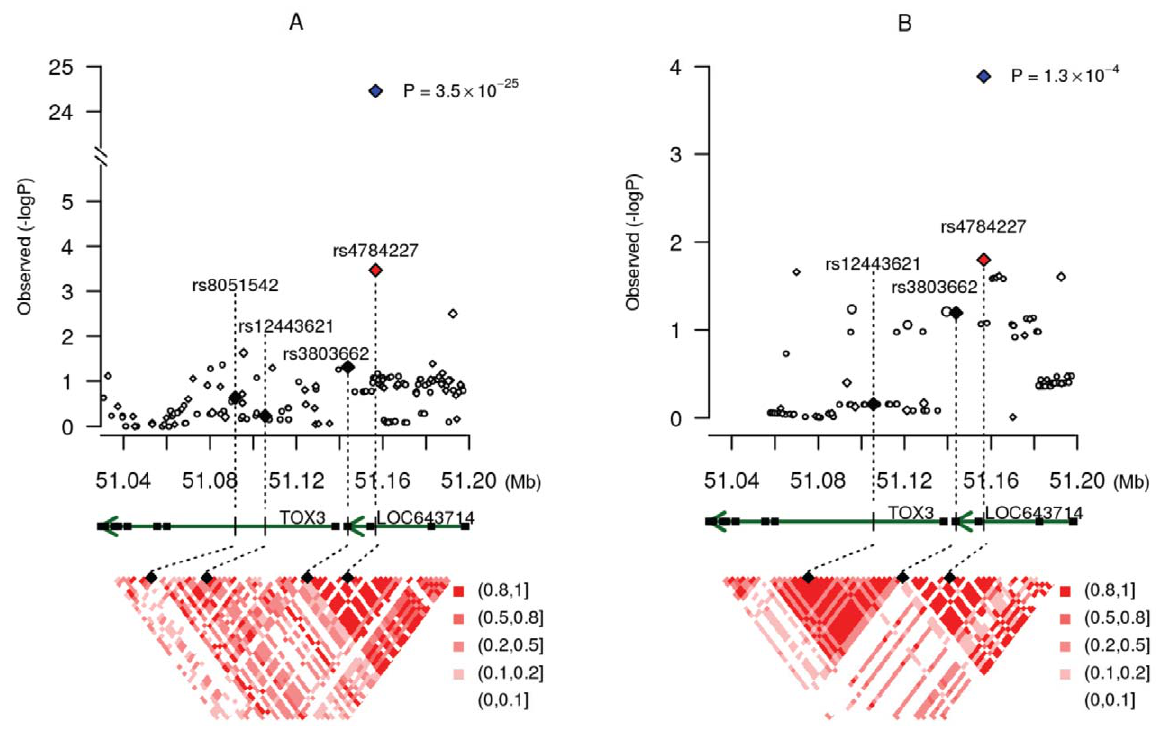
Figure 2. SNP association at 16q12 with breast cancer risk. In SBCS (A) and CGEMS (B). Top panel: Results (-log 10 P) are shown for the associations of breast cancer risk with directly genotyped (diamonds) and imputed (circles) SNPs located in the TOX3 and LOC643714 genes. P-values for rs4784227 are shown in red for Stage I data and in blue for the combined data. The three previously-reported SNPs (rs8051542, rs12443621, and rs3803662) are highlighted in black. Middle panel: Genomic view at 16q12.1. Gene locations are from the March 2006 UCSC genome browser assembly. Bottom panel: Estimates of pairwise LD (r 2 ) for common SNPs (with MAF $ 5%) from HapMap release 23a in the region from 10 kb downstream of rs8051542 to 10 kb upstream of rs4784227.